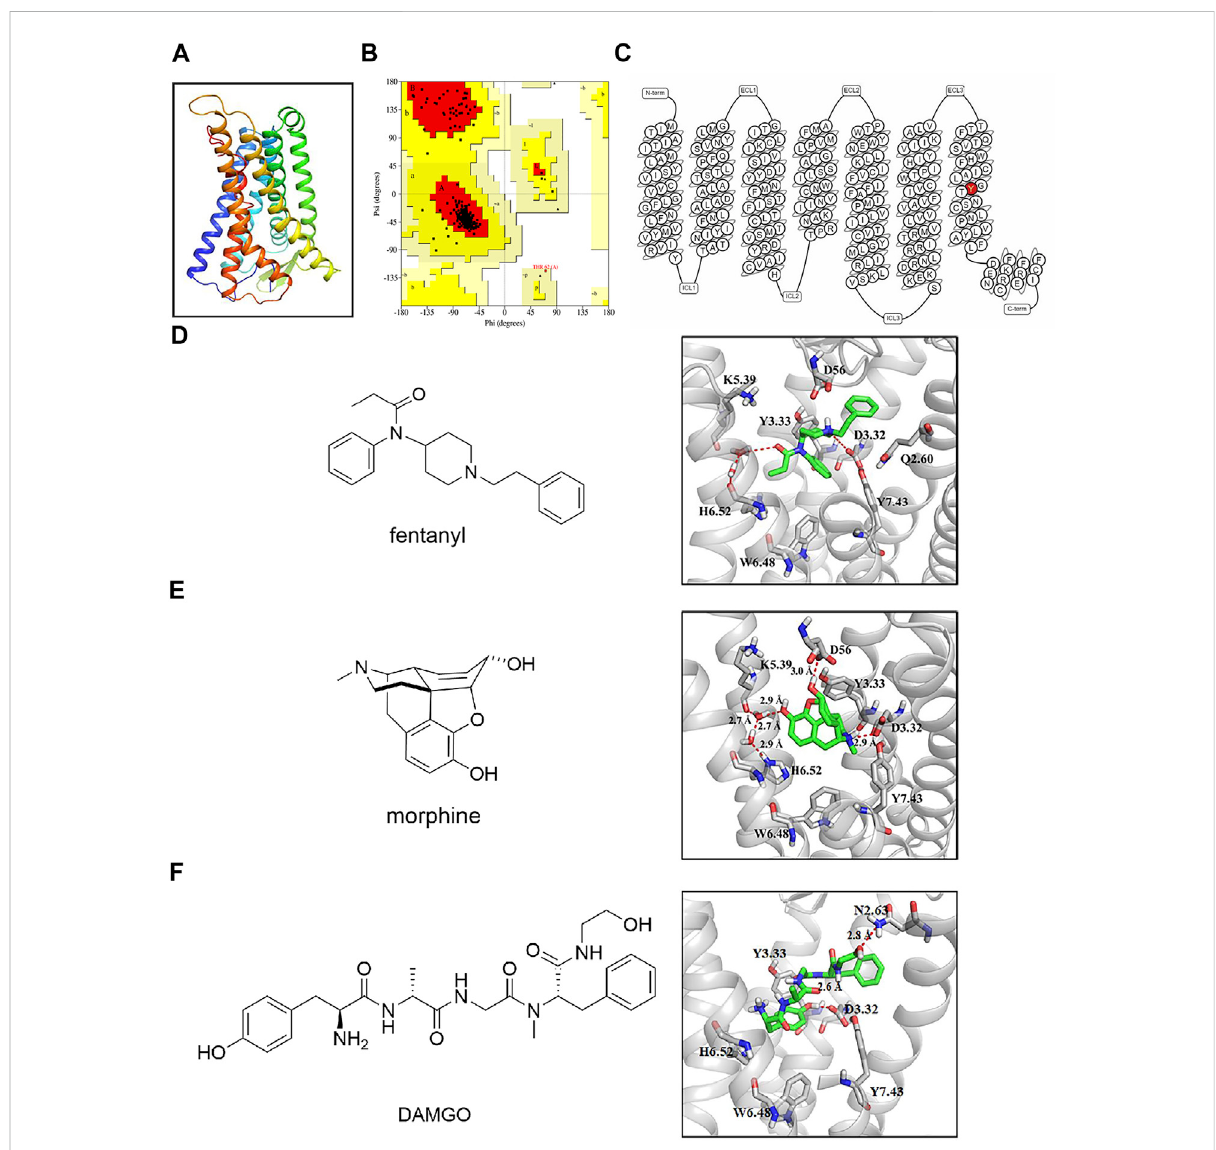
FIGURE 1 Binding mode of agonists with active µ-opioid receptor (MOR). (A) three-dimensional structure model of Homo sapiens MOR. (B) Ramachandran plot of active MOR model from active Mus musculus MOR. (C) snake diagram of MOR with residue Y7.43 highlighted in magenta. Image created from www.gpcrdb.org. (D – F) binding mode ofagonists with active MOR. Active MOR is shown ingray ribbons; residuesare shown as a gray ball – stick model. Hydrogen bond is shown as a dashed line. Agonists are shown as a green ball – stick